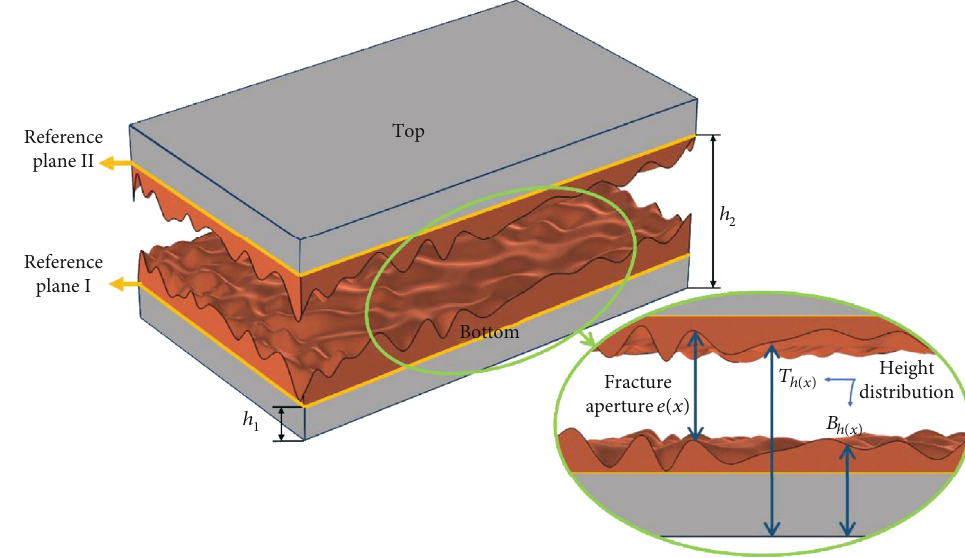
Figure 5: The relative position of the surfaces.